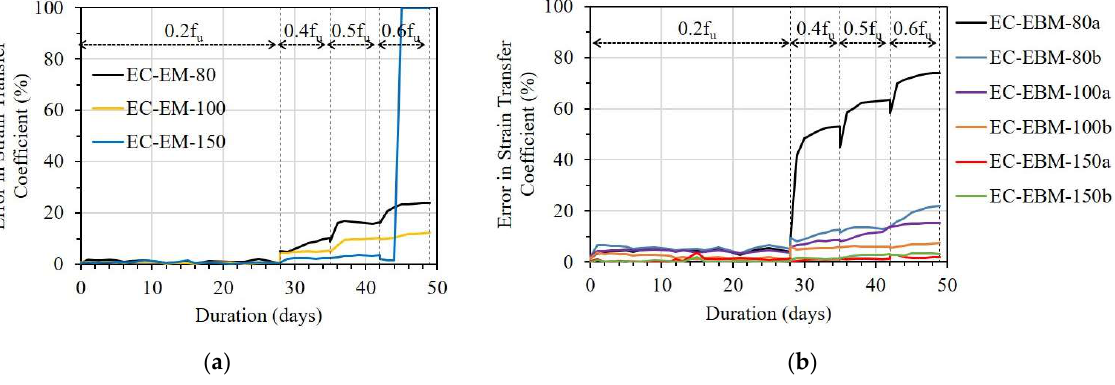
Figure 17. The error in strain transfer coefficient of the EC specimen with different bond lengths: ( a ) Embedded method and ( b ) Externally bonded method.